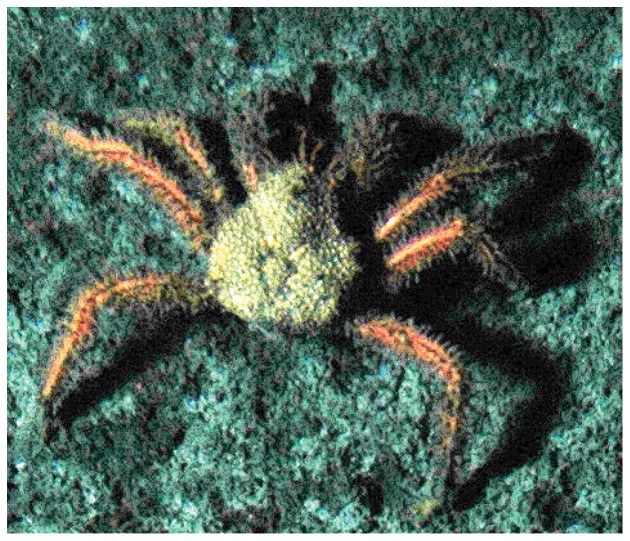
A second type of lithodid crab that we observed rarely at Md. 12 (tentatively identified as Paralomis papillata relative).